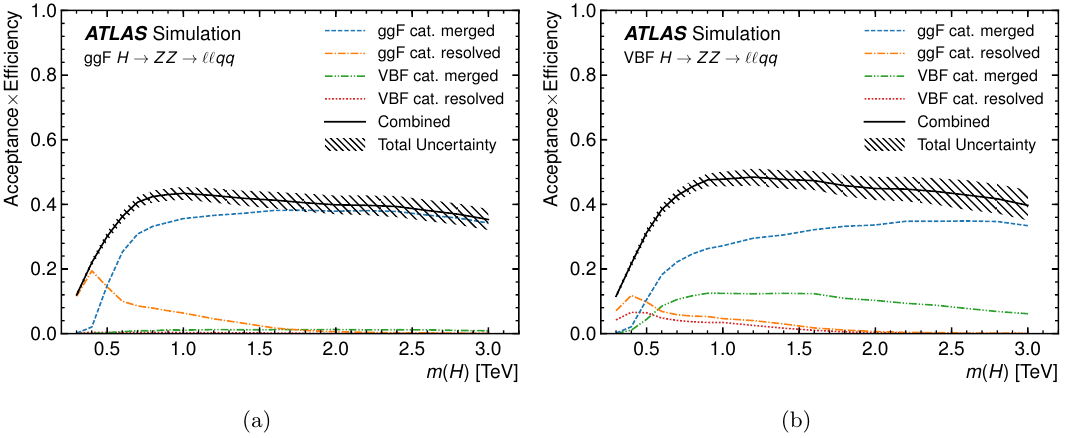
Figure 4 . Selection acceptance times e(cid:14)ciency for the H simulations as a function of the Higgs boson mass for (a) ggF and (b) VBF production, combining the HP and LP signal regions of the ZV of the ZV ‘‘jj selection. The hatched band represents the total statistical and systematic !